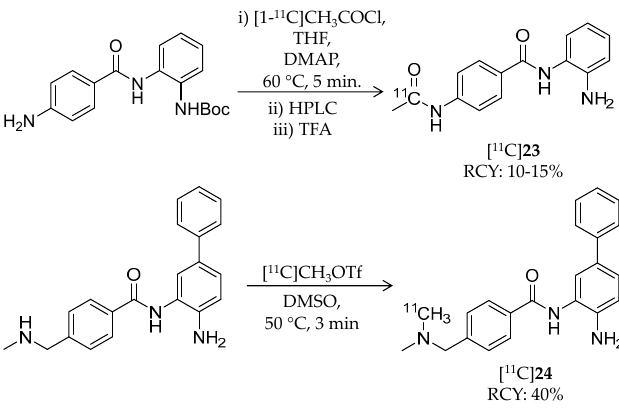
Table 5. Brain PET imaging studies of HDAC radioligands in NHPs.